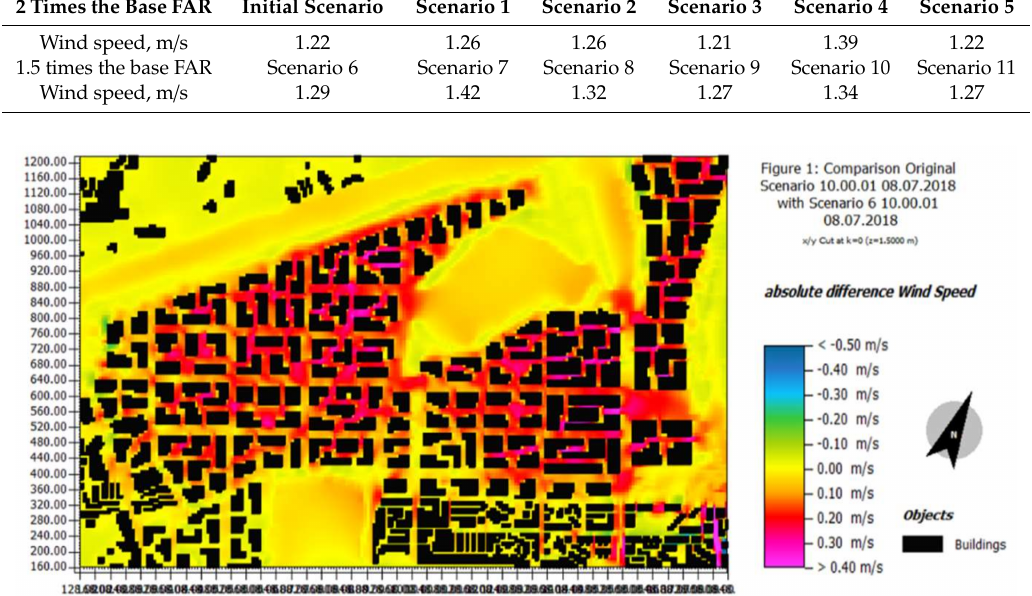
Figure 10. Wind speed di ff erences between the initial scenario and Scenario 6 (2 times versus 1.5 times the base